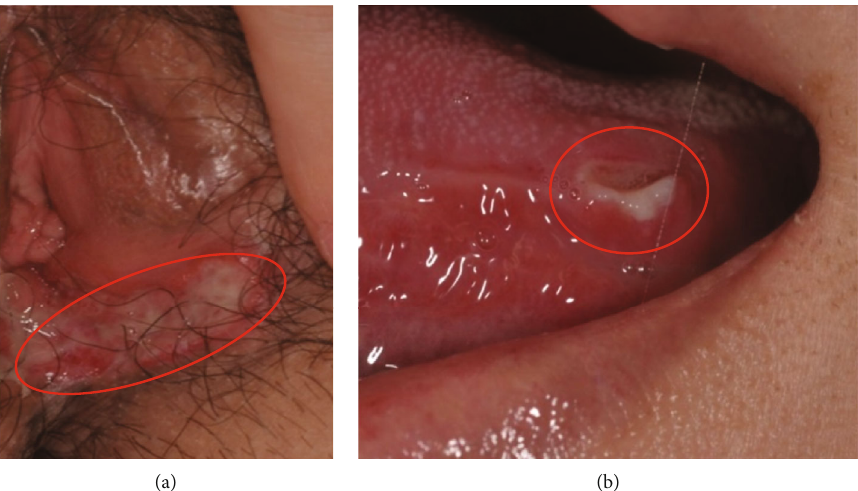
Figure 1: (a) A genital ulcer identi fi ed on the inside of the left labia minora (red circle). (b) A 5mm aphthous ulcer (red circle) on the left side of the tongue.